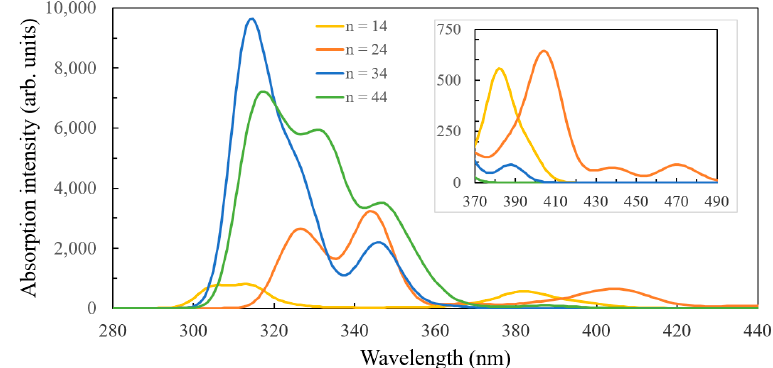
Figure 20. Simulated UV–Vis absorption spectra of the systems consisting of the PV molecule adsorbed on the Ti n O 2 n +2 H 4 clusters ( n = 14, 24, 34, 44), calculated by TD-DFT at the B3LYP/LANL2DZ level in water solvent. The inset shows details of a higher wavelengths range. The spectral lines were convoluted with Gaussian distributions of 1000 cm − 1 full width at half maximum.